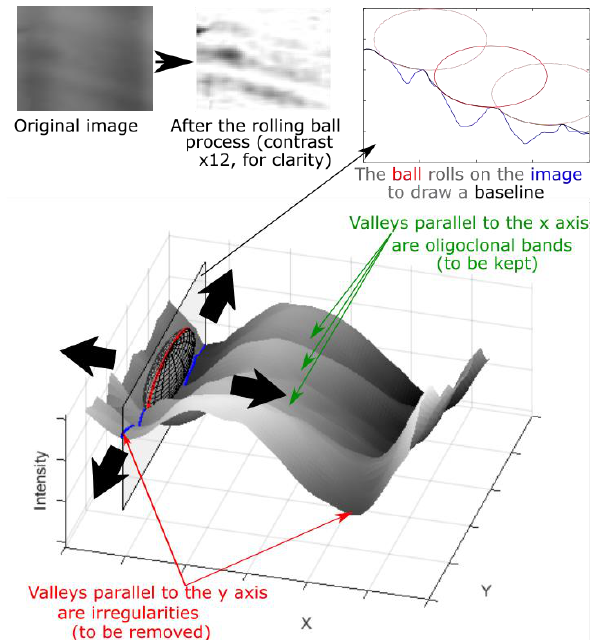
Figure 3. Illustration of the rolling ball approach for background and vertical irregularities subtraction: the ellipsoid falls into the valleys to be removed and rolls over the valleys to be preserved.